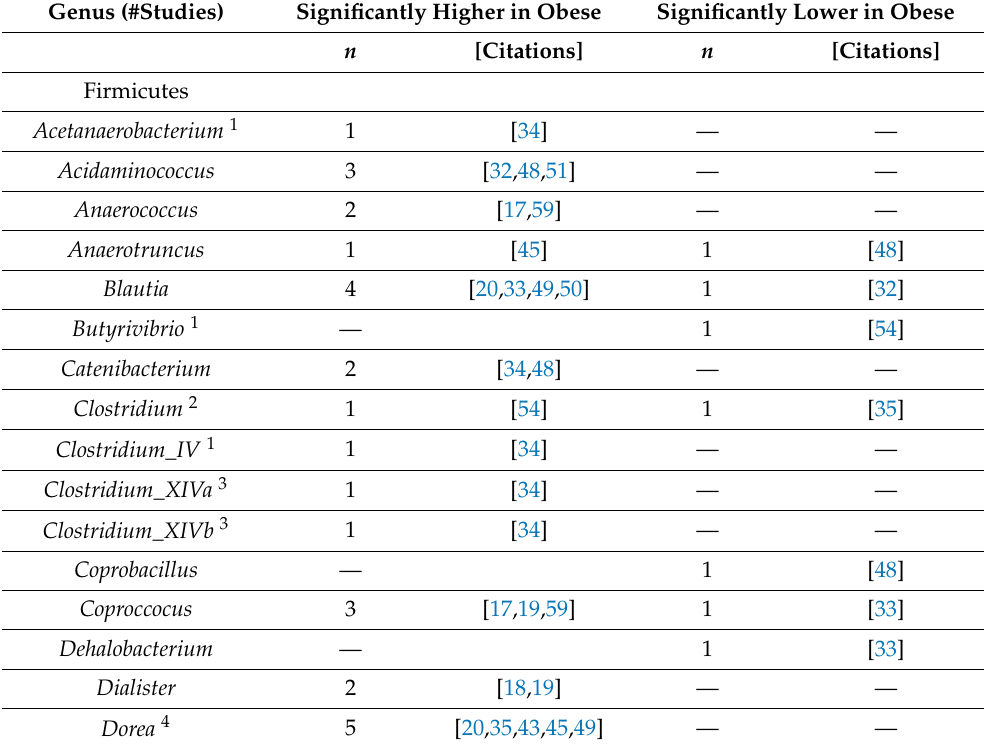
Table 4. Significant differences in the relative abundance of bacteria at genus level between obese and non-obese